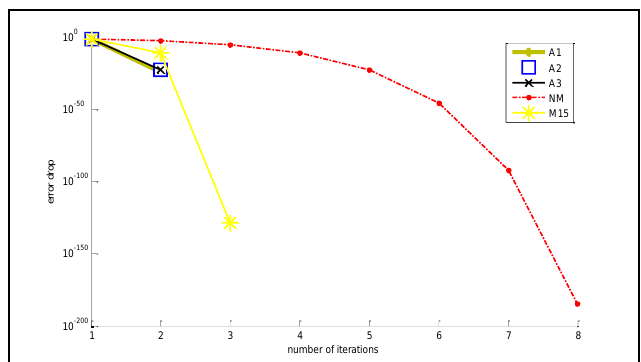
Fig. 14. CPU times in Examples